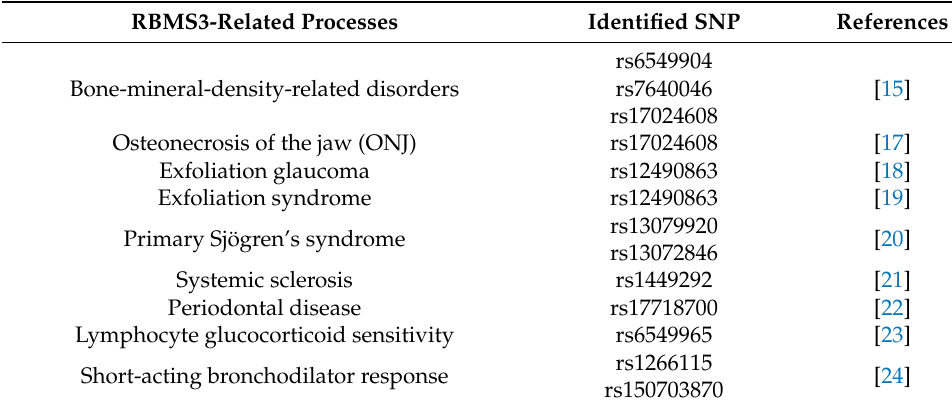
Table 1. Single-nucleotide polymorphisms of the RBMS3 gene and their correlation with pathological processes. RBMS3-Related Processes Identified